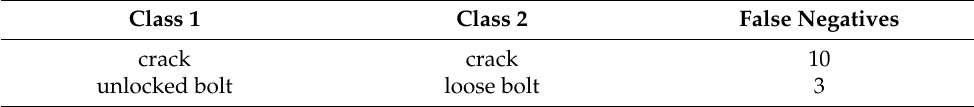
Table 12. False negatives for damage diagnosis (model 1).